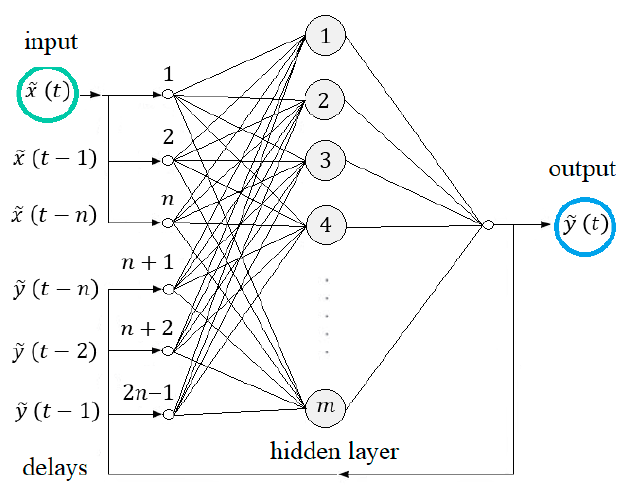
Figure 3. Example of a recurrent NARX ANN architecture with 1 hidden layer, m neurons and n time delays.